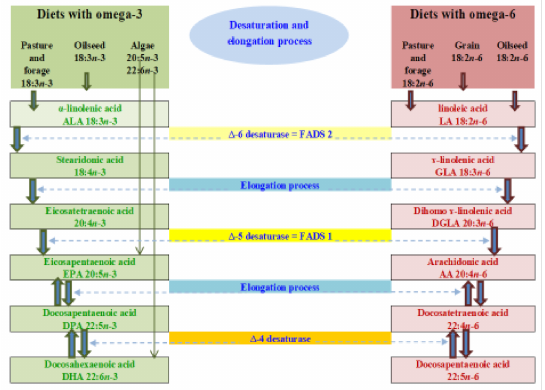
Figure 2. Dietary sources and biosynthesis of omega-3 and omega-6 fatty acids through enzymatic desaturation and elongation processes adapted from Ponnampalam et al. [23].